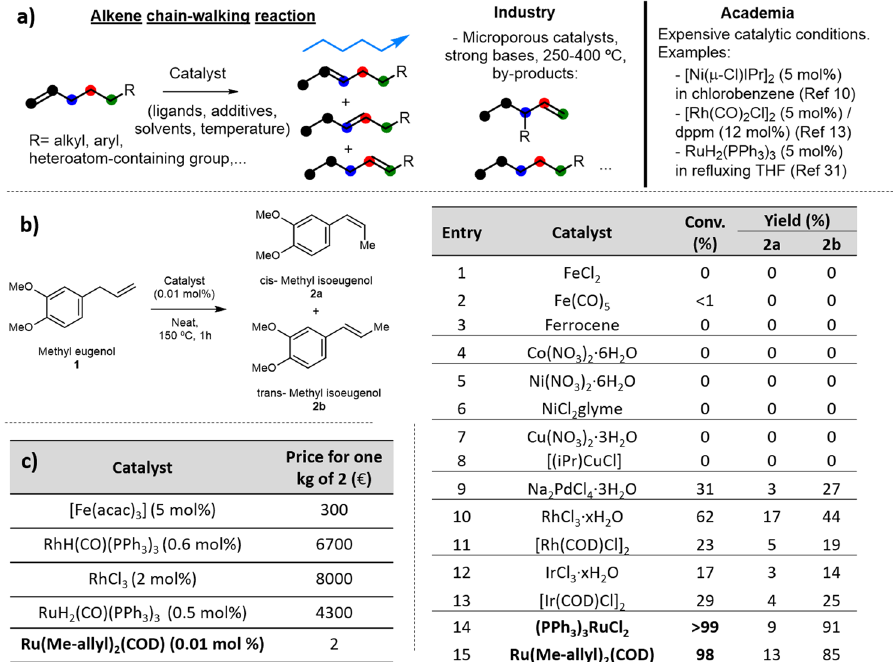
Fig. 1 Parts – per – million (ppm) of Ru catalyze the chain – walking reaction of terminal alkenes. a The general alkene chain – walking reaction and some precedents and drawbacks in industry and academia. b Catalytic results for the isomerization of methyl eugenol 1 with 0.01 mol% (100 ppm) of different metal salts and complexes in the neat alkene at 150 °C for 1 h. c Price of catalyst required to get one kilogram of methyl isoeugenol 2 ( 2a + 2b